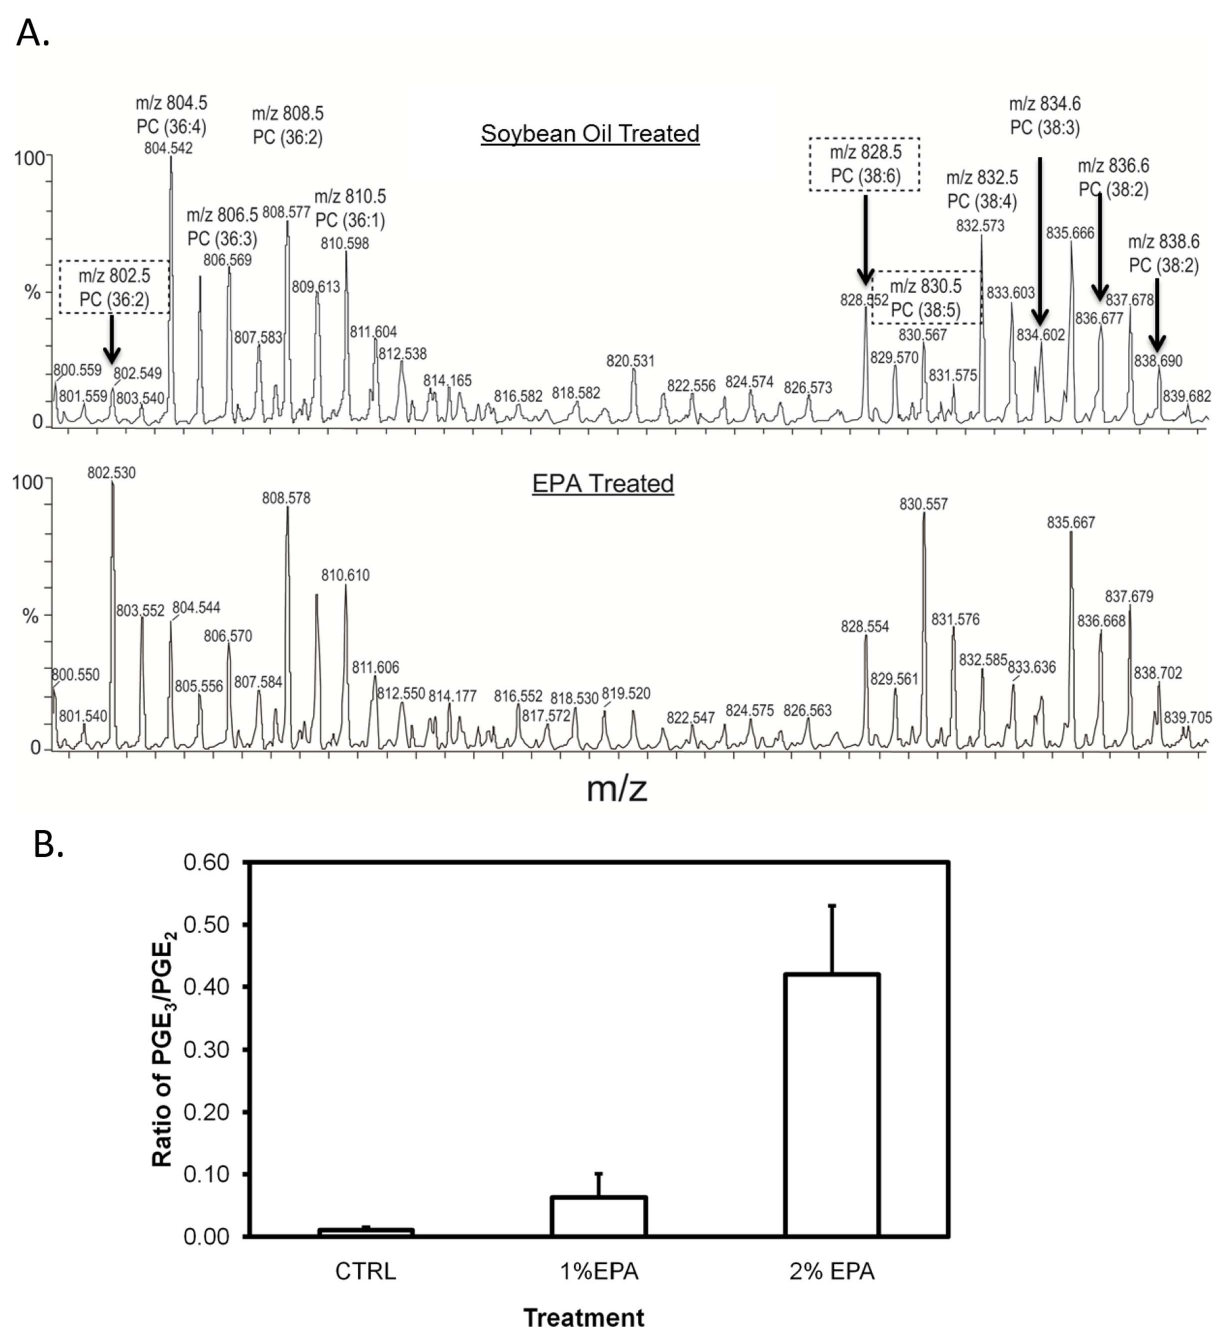
Figure 7. Lipid metabolism in lung tumor tissues from K-ras transgenic mouse. A). MALDI mass spectra collected directly from tumor tissue lysates of K-ras mutant lung tumors, either untreated or treated with EPA. Observed shifts in lipid catabolism from AA to EPA are boxed, showing significant changes in tumor metabolism. B). Ratio of PGE 3 /PGE 2 extracted from tumor tissue derived from the K-ras transgenic mouse model. PGE 2 and PGE 3 were quantified by LC-MS/MS. These data represent the tumor’s metabolism shift from producing AA derived PGE 2 to PGE 3 from EPA thus eliciting an anti-proliferative